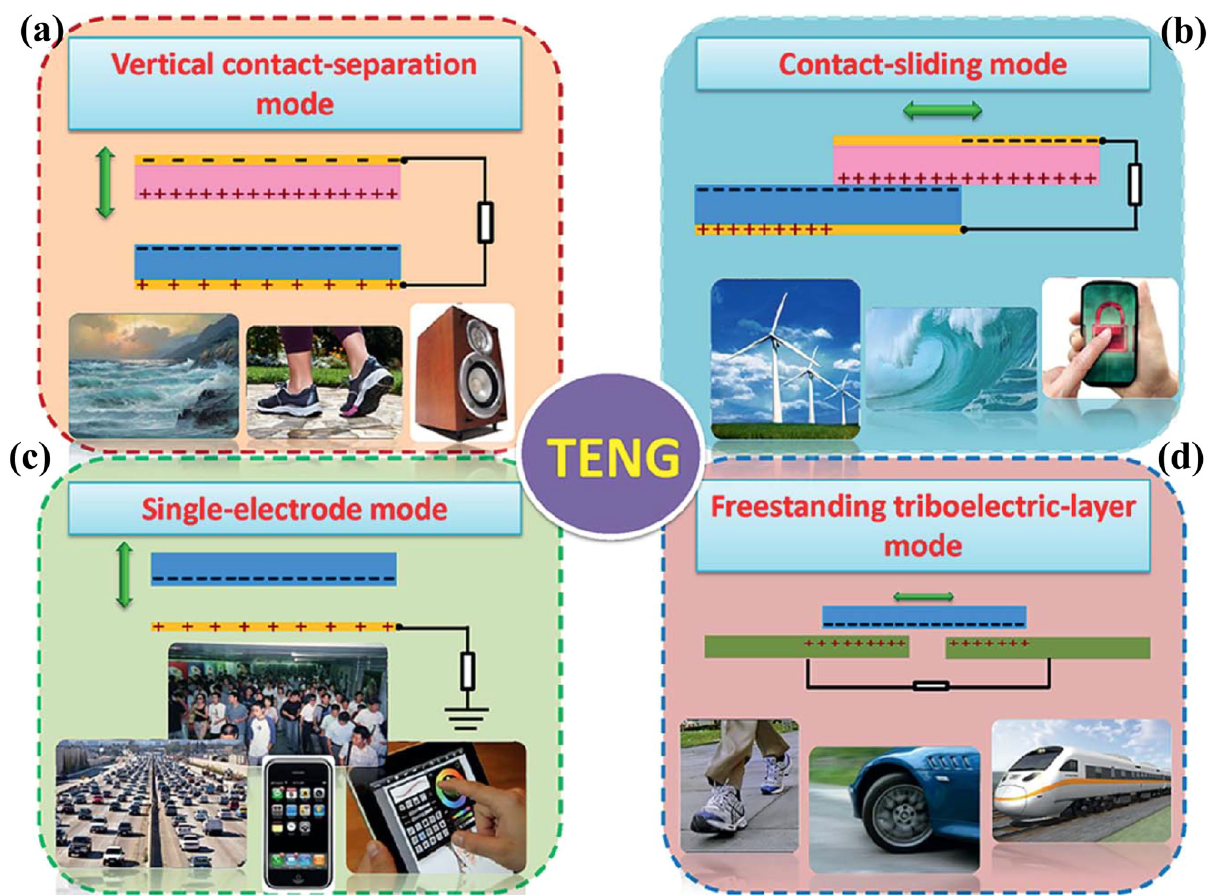
Figure 1: The fundamental modes of TENGs: ( a ) vertical contact - separation mode, ( b ) contact - sliding mode, ( c ) single - electrode mode, and ( d ) freestanding triboelectric - layer mode [ 43 ]